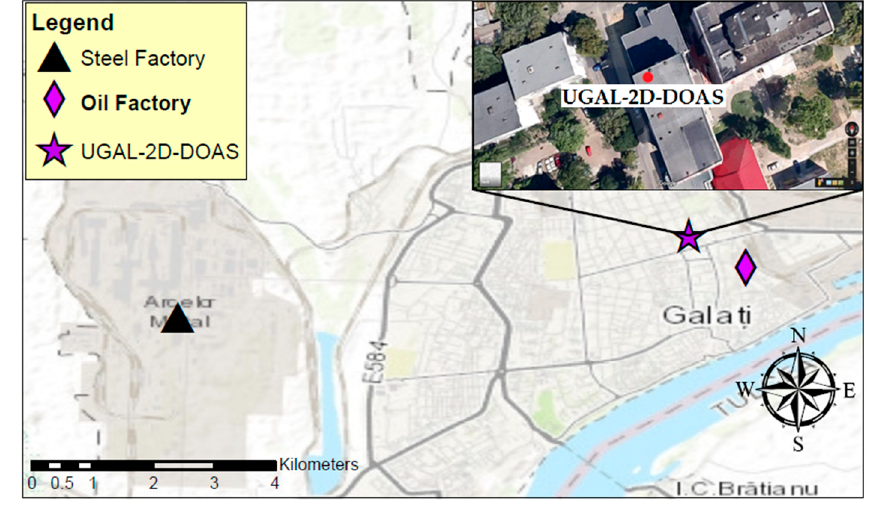
Figure 3. Location of the experiments using the UGAL-2D-DOAS system (image adapted from Google Earth [40] and ArcGIS v10.4).